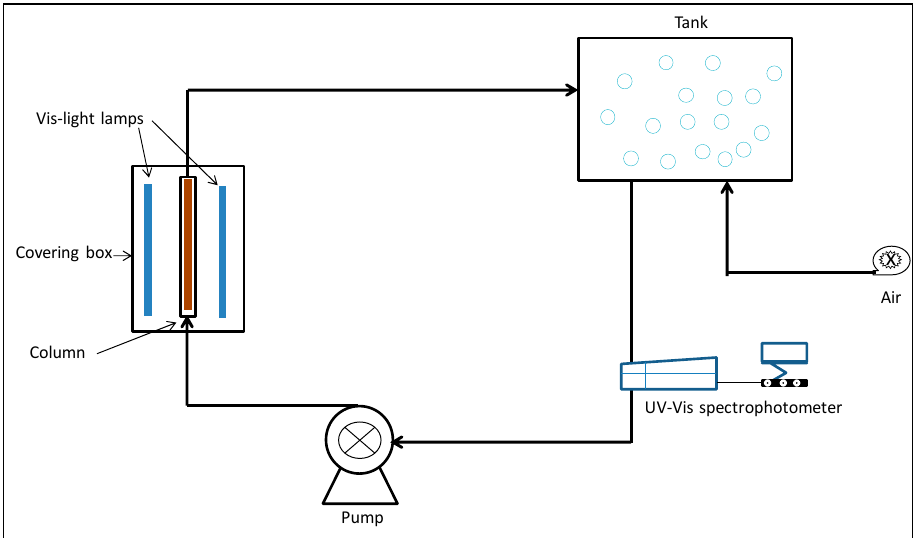
Figure 1. Schematic diagram of the photocatalytic reactor continuous flow system.